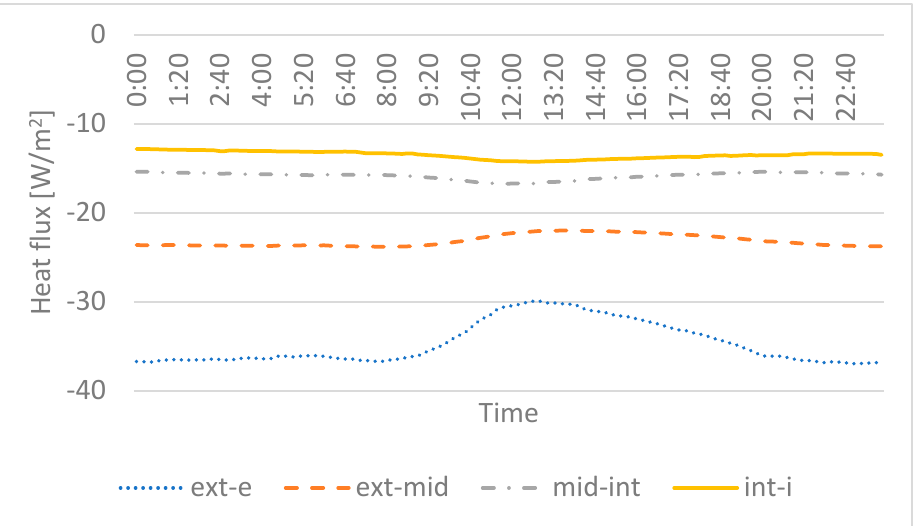
Figure 15. Heat fluxes between the layers on 8 January 2021. The flux exchanged by the outer wall surface is negative for 24 h a day, therefore it has the direction of heat escape from the wall. The incident solar radiation reduces the net loss but does not change the flow direction. The stream from inside the room is also negative, which means, however, that the wall is heated from the inside. The power of this heating is about three times less than the power of external losses. Comparing the results with [32], it can be seen that in this study greater differences between summer and winter were obtained. It is caused by more different values of solar radiation and outside temperature. The heat flux flowing between the middle and inner layers is greater than between the inner environment and the wall surface. This is probably the influence of the boundary conditions in the previous days.